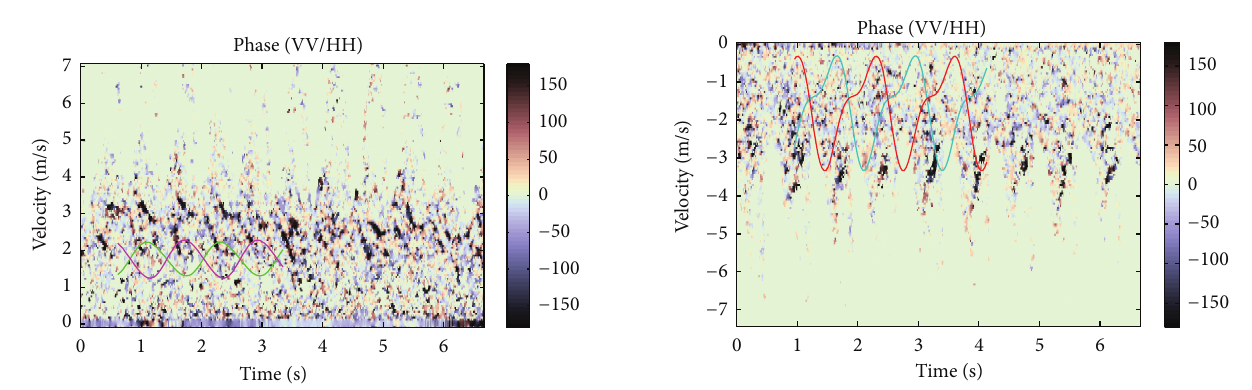
Figure 2: Polarimetric measurement of human walking toward the radar. The red (and yellow) double-bounce areas correspond to the elbow motion, while the blue (and green) single bounce is the rest of the body.